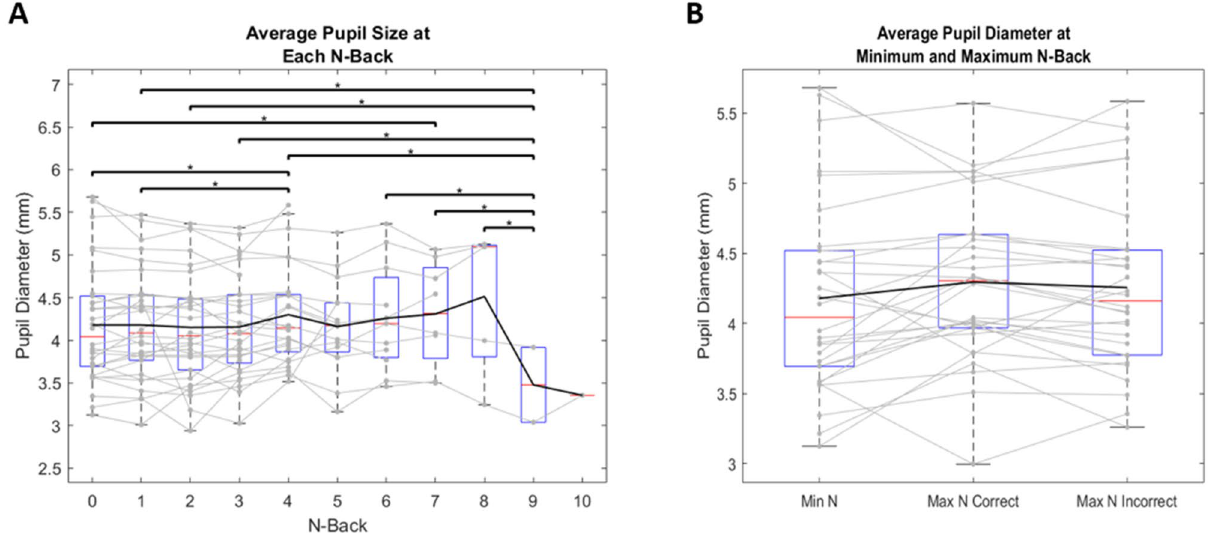
Figure 5. Mean pupil size as a function of N-back. Black line represents mean values. Solid gray lines represent individual subjects. Red lines represent median values. Blue boxes represent the IQR where each lower bound signifies Q1 and each upper bound signifies Q3. Lower and upper bounds of grey dotted lines represent minimum and maximum values, respectively. Points that lie outside these bounds are considered outliers. One star represents a significance value of p < 0.05, two stars represents a significance value of p < 0.01, and three stars represents a significance value of p < 0.001. ( A ) Pupil size increases gradually with increasing N-back, mainly at an N = 4 (most commonly reached maximum N-back), then constricts abruptly once N-back exceeds 8. ( B ) Average pupil size within subjects separated into minimum cognitive load (Min N) and maximum successful cognitive load (Max N Correct) and surpassed cognitive load (Max N Incorrect).